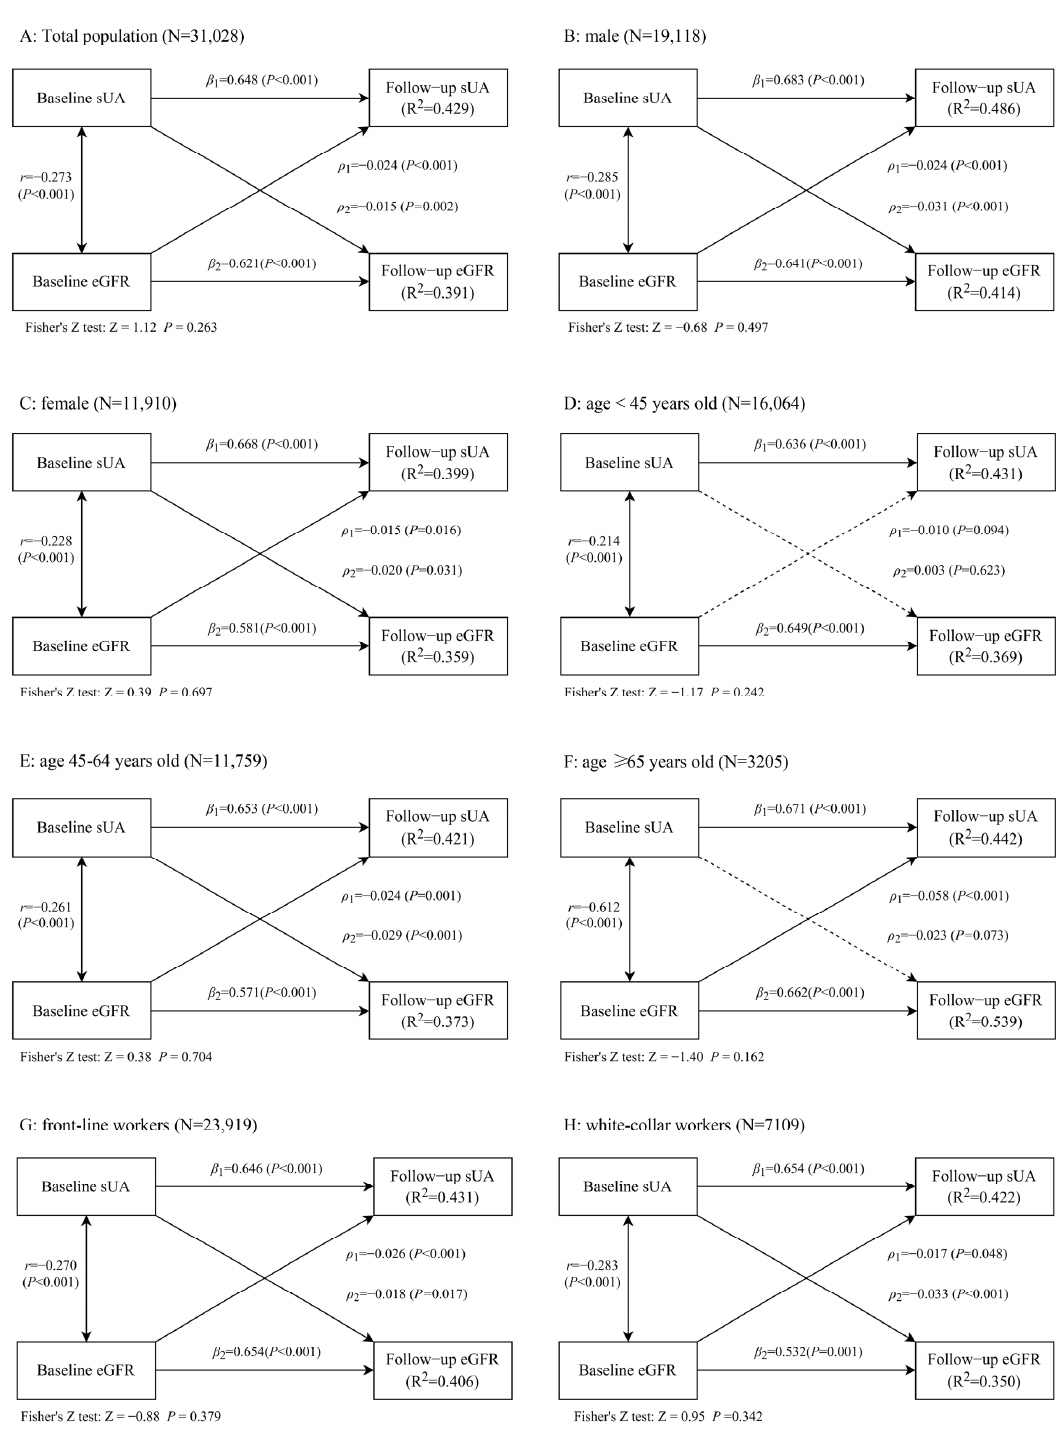
Figure 5. Sub-analyses of the cross-lagged model of the association between sUA with eGFR, stratified by gender, age, and occupation.